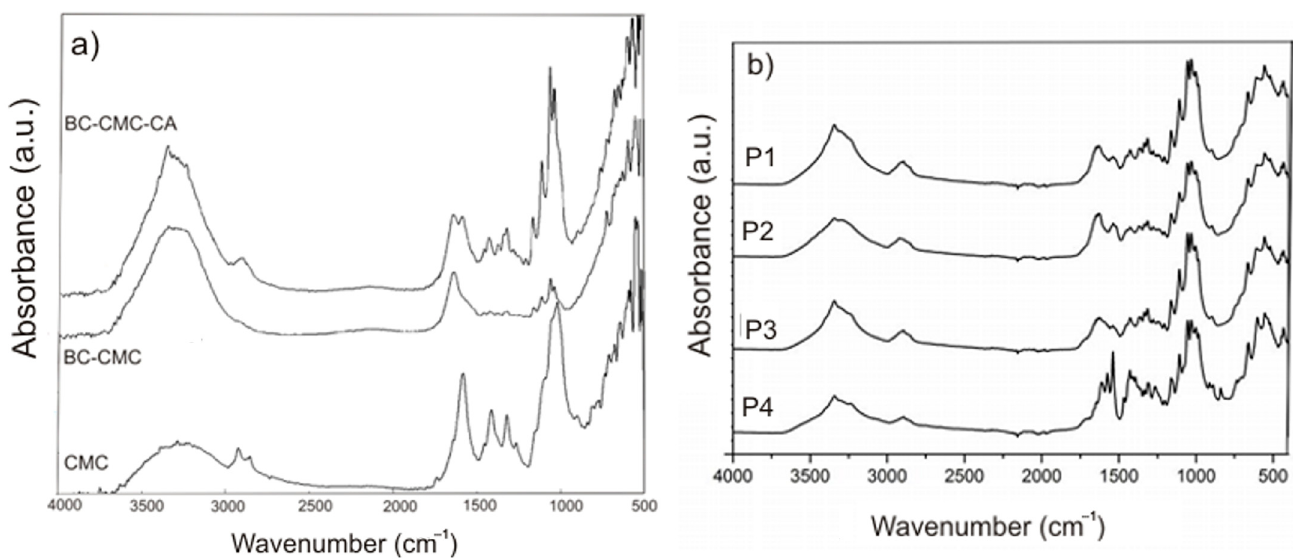
Figure 2. FTIR spectra of: ( a ) CMC, BC–CMC composite and BC–CMC composite crosslinked with CA and ( b ) samples P1–P4.